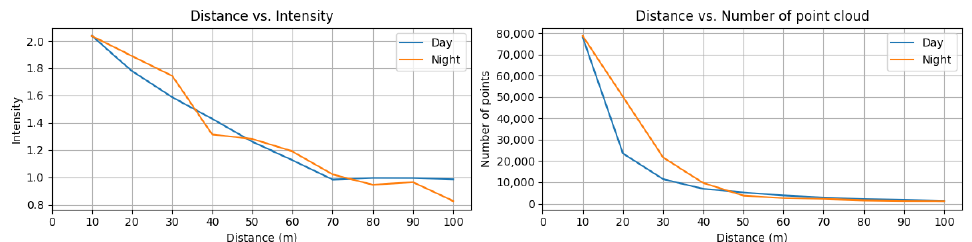
Figure 14. ( Left ) mean intensity of captured points according to the distance in day/night ( Right ) number of captured points according to the distance in